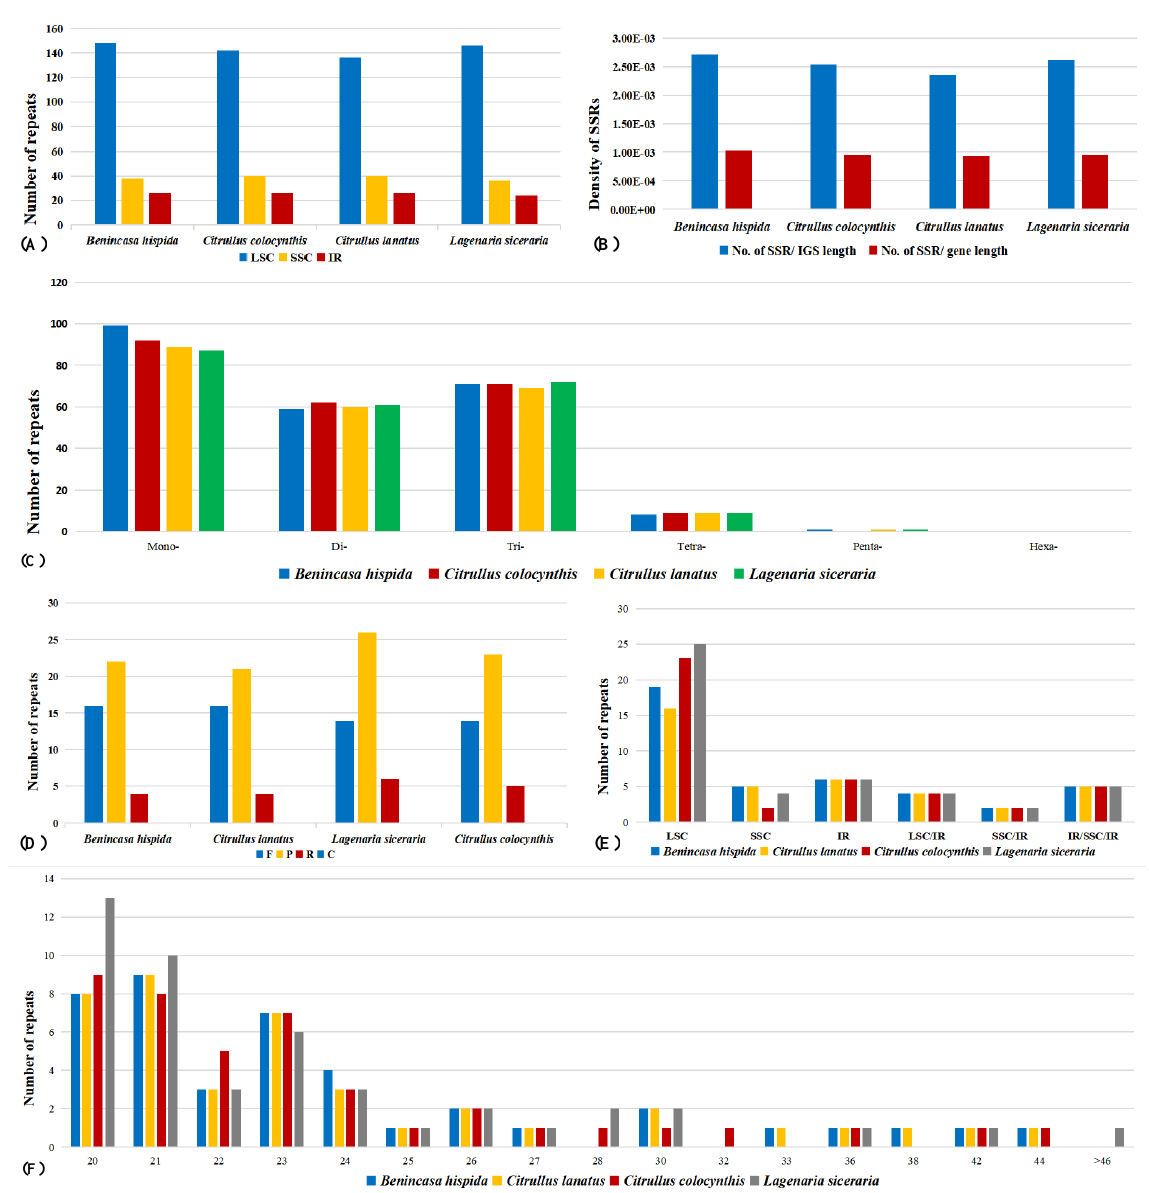
Figure 2. Comparison of microsatellites and oligonucleotide repeats in the chloroplast genomes of Benincaseae species . ( A ) The number of SSRs in the three main regions of the chloroplast genome. LSC: large single-copy region, SSC: small single-copy region, IR: inverted repeat region. ( B ) The density of the SSRs in the IGSs (intergenic sequences) and gene regions. ( C ) The number of different types of SSR. Mono- represent mononucleotide SSRs, Di- represent dinucleotide SSRs, etc. ( D ) Different types of oligonucleotide repeat. F: forward repeats, P: palindromic repeats, R: reverse repeats, C: complementary repeats. ( E ) The number of oligonucleotide repeats in different regions. LSC: large single-copy region, SSC: small single-copy region, IR: inverted repeat region, LSC/IR: repeat sequences crossed LSC and IR regions, etc. ( F ) The number of repeats in different repeat